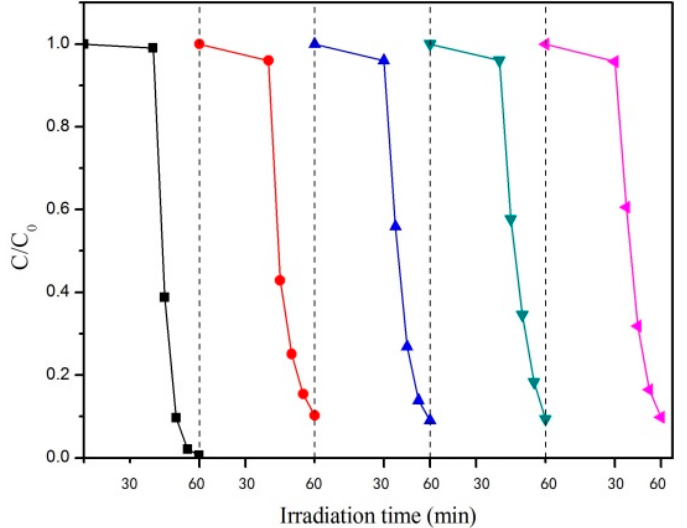
Figure 4. Cyclic curve of the degradation of methyl orange by CaCO 3 –TiO 2 composite photocatalyst.